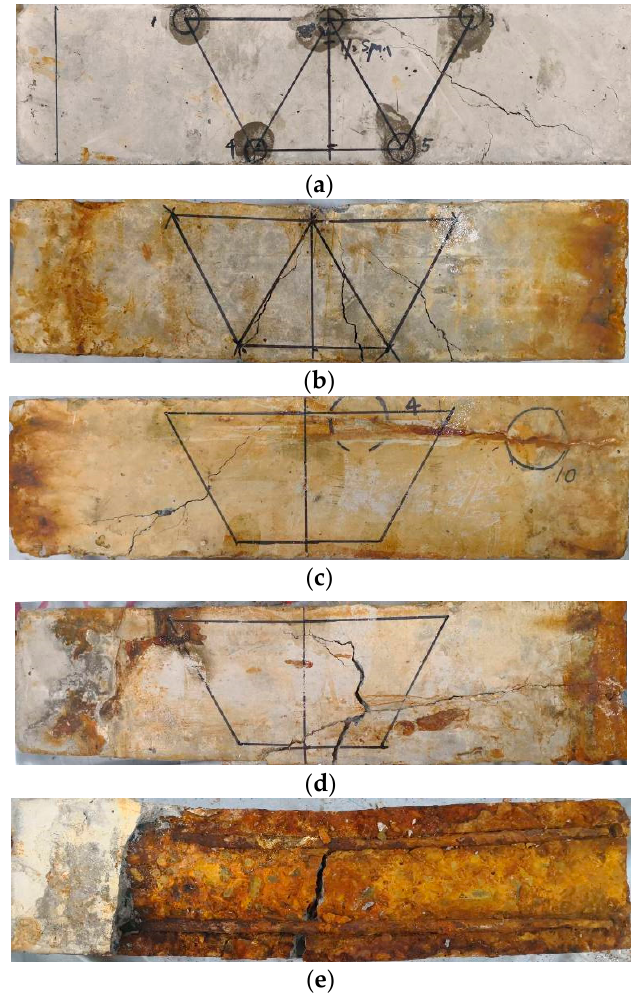
Figure 7. Failure forms of corroded reinforced concrete (RC) beams: ( a ) Uncorroded RC beam; ( b ) 10% corroded RC beam; ( c ) 20% corroded RC beam; ( d ) 30% corroded RC beam; ( e ) 40% corroded RC beam.